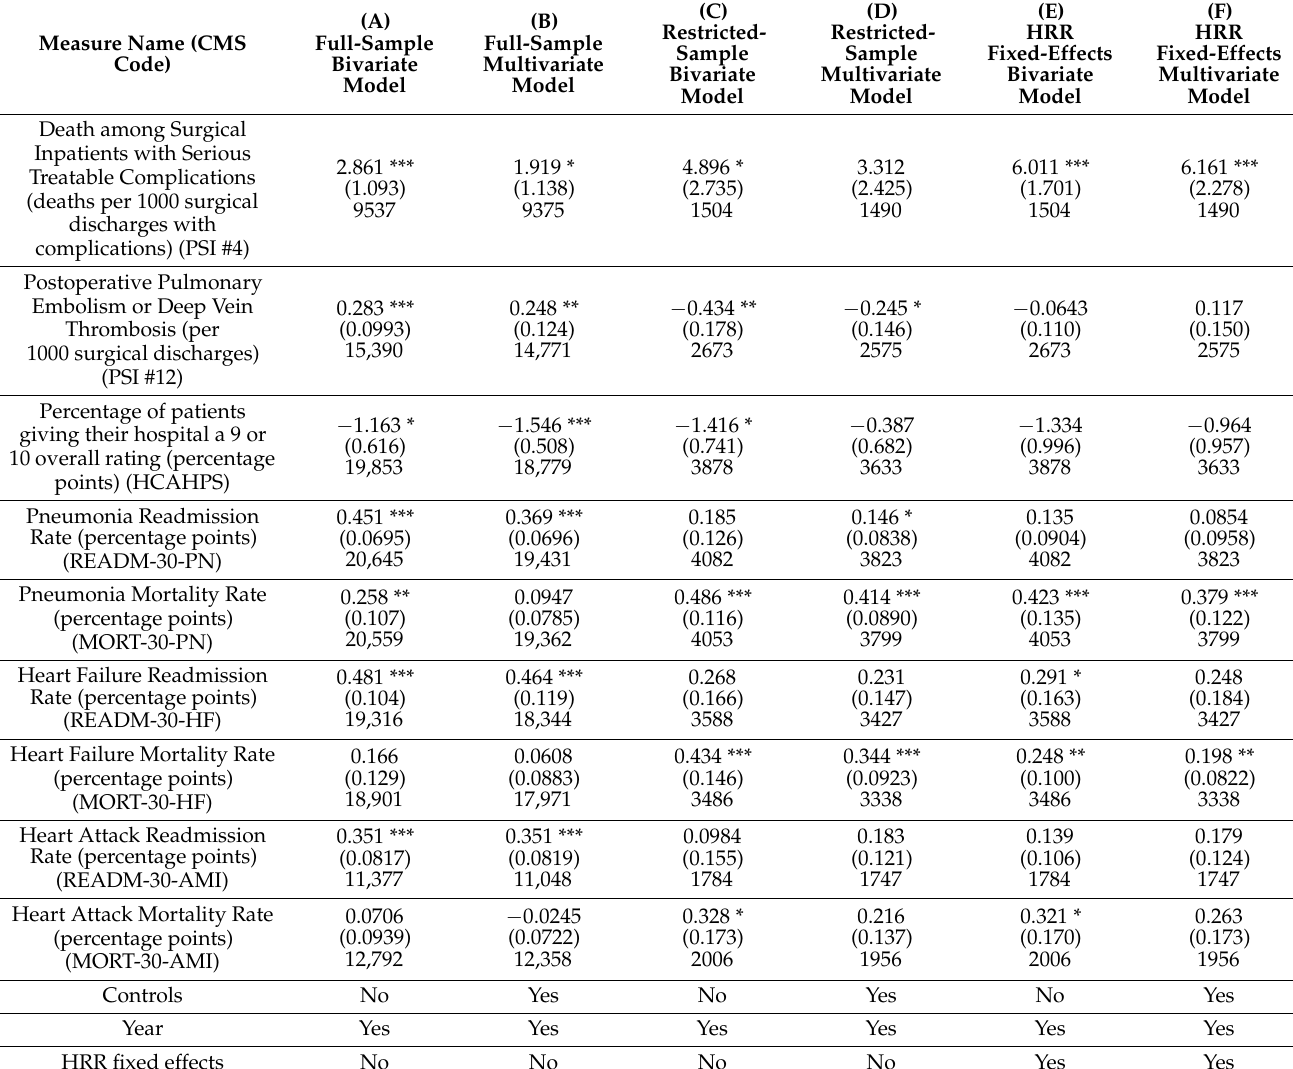
Table 7. Pooled regression results